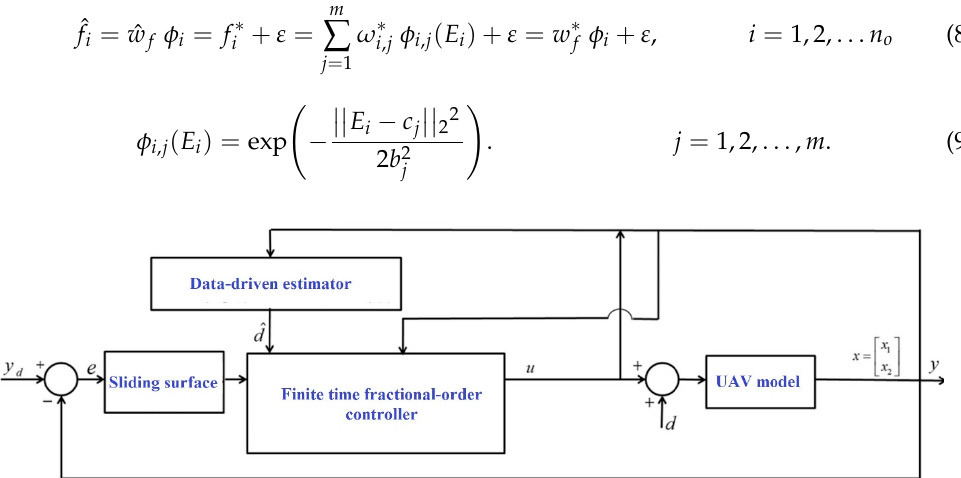
Figure 3. Block diagram of data-driven-based TSMC for UAV